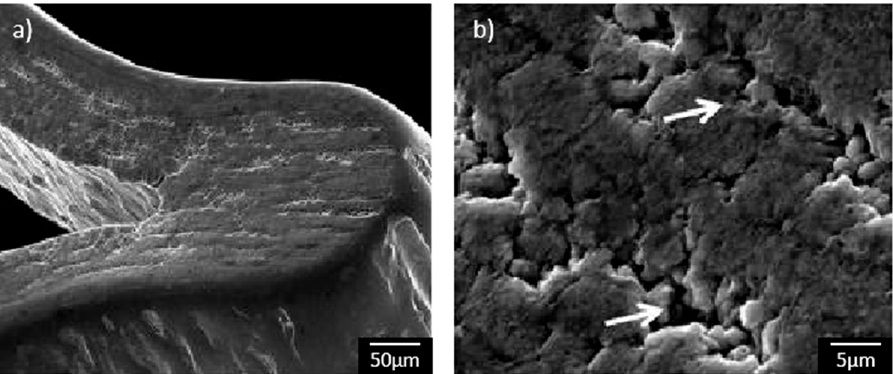
Figure 7. SEM micrographs pictures for P14 showing the presence of pits on the surface (arrows indicate pits); Magnification; ( a ) 400 × ; ( b ) 4000 × .